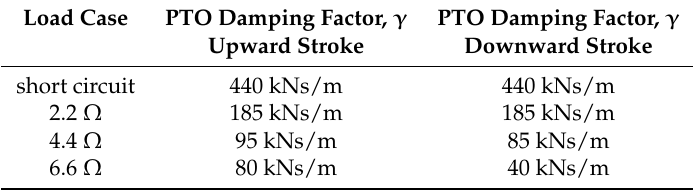
Table 5. The damping factor γ at full stator overlap for each load case used in the low speed